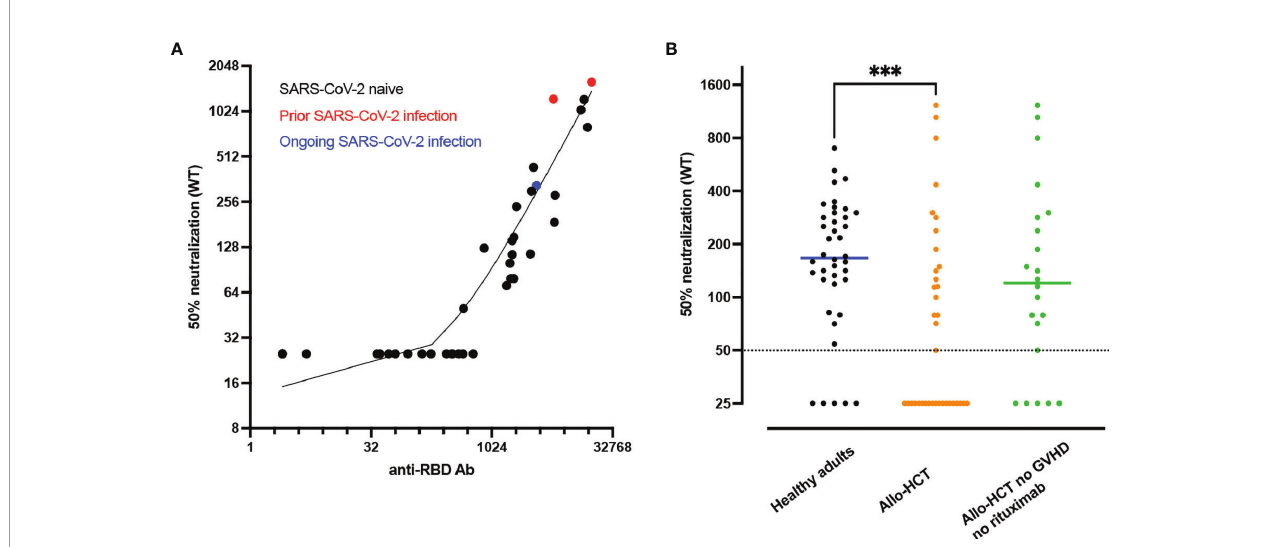
FIGURE 2 | Lower neutralizing antibody (Ab) responses in allogeneic hematopoietic stem cell transplant (allo-HCT) patients than in healthy adults. (A) Correlation between anti-RBD Ab and 50% neutralizing Ab titers of SARS-CoV-2 wild type at 28 days after second dose in allo-HCT patients (n=40). The red dots show the data from the two patients with prior SARS-CoV-2 infection while the blue dot shows the data of the patient with ongoing SARS-CoV-2 infection at fi rst vaccination. (B) 50% neutralizing Ab titers of SARS-CoV-2 wild type at 28 days after second dose in SARS-CoV-2 naive healthy adults (staff members of nursing homes, n=40, black dots) versus SARS-CoV-2 naive allo-HCT patients (n=37, orange dots) and SARS-CoV-2 naive allo-HCT patients without moderate/severe chronic graft- versus-host disease (GVHD) and rituximab (anti-CD20) administration in the year before vaccination (n=22, green dots). The horizontal solid lines show the median and the broken line shows the lower limit of quanti fi cation (LLOQ, 1/50). ***P value < 0.001. Figures from Canti et al.